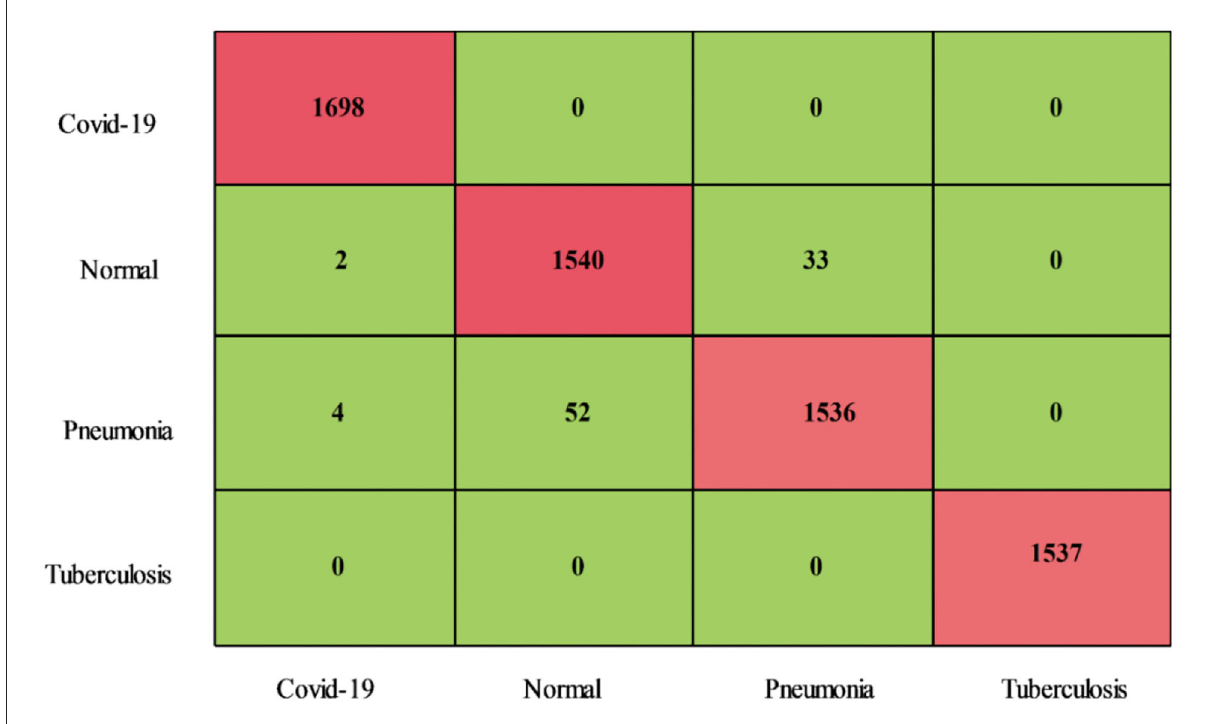
FIGURE16 Confusion matrix of chest X-ray dataset for proposed optimization method.